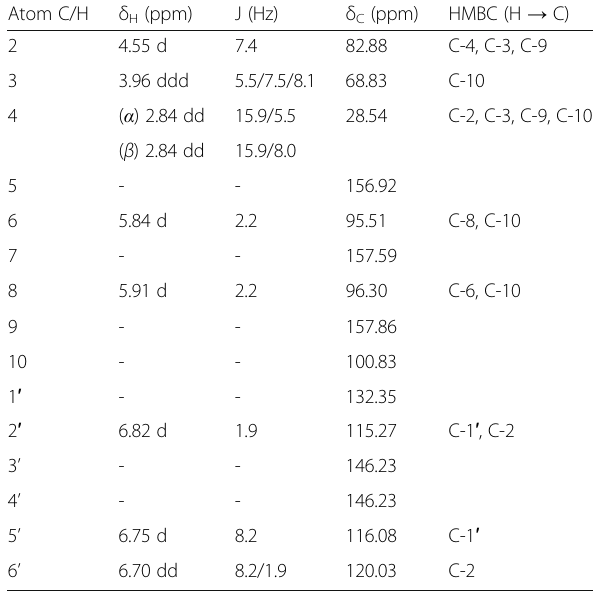
Table 1 Spectral determination of (+/ − ) catechins in 1 H-NMR and 13 C-NMR a